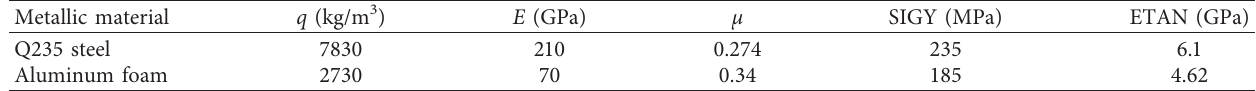
Figure 1: Three-dimensional microscopic view of double-layer foam aluminum. Table 1: Metal material parameters.